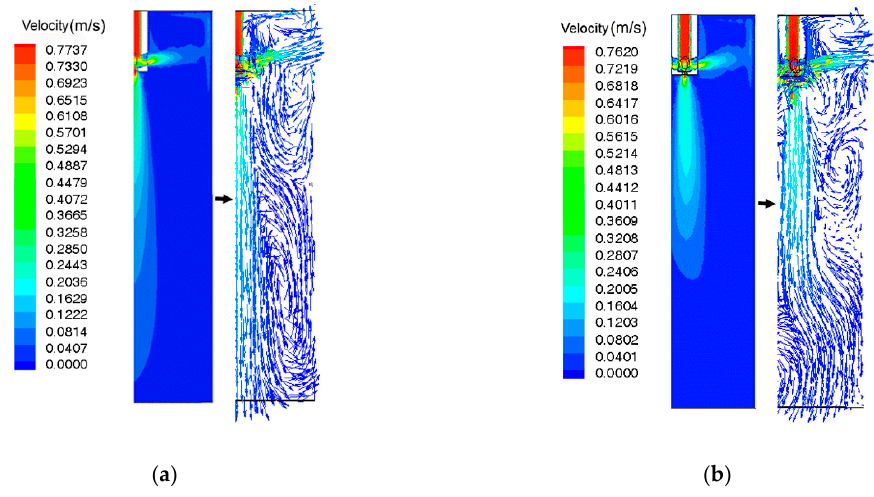
Figure 16. Flow fields of molten steel in the mold with different conditions. ( a ) Five-furcated SEN with outlets in tangential direction with the same axis; ( b ) Five-furcated SEN with outlets in tangential direction with deviation from the center of 50 mm.